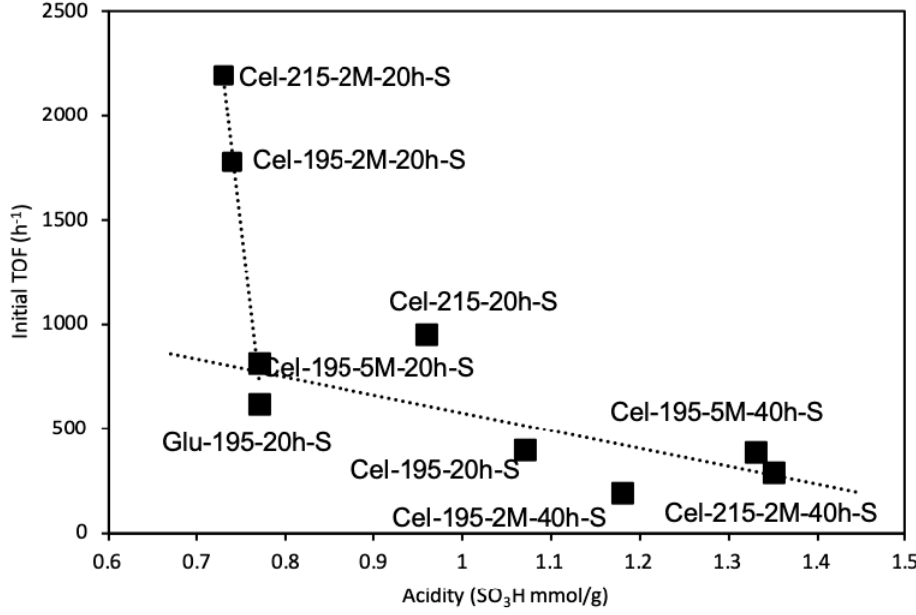
Figure 8. Initial TOF in solketal synthesis vs. sulfonic acidity plot with fresh SHTCs as catalysts ( reaction conditions: acetone: glycerol molar ratio 7:1, catalyst 1% w/w with respect to glycerol, 25 °C).